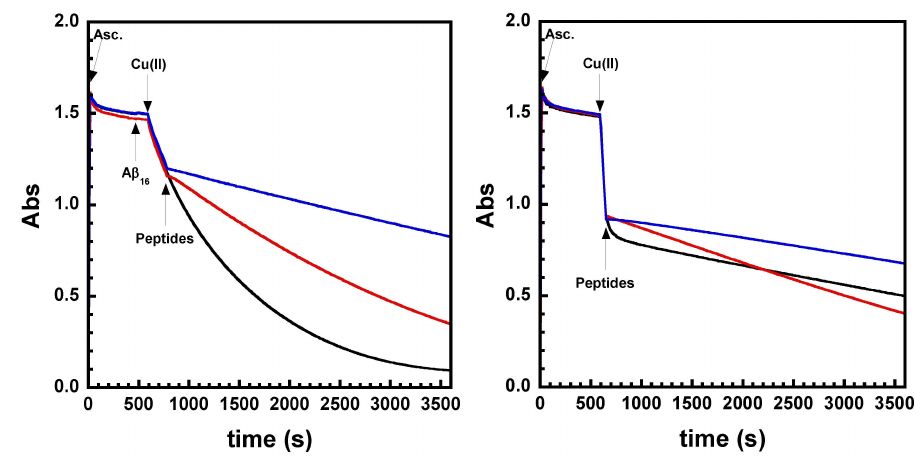
Figure 1. Ascorbate consumption (measured at λ = 265 nm) as a function of time. Ascorbate was added first, followed by A β 1–16 (right panel) after 6 min, and Cu II after 10 min, and the peptides (AH in red, AAH in black, and AHH in blue) when an absorbance of 1.0 ( left ) or 1.2 ( right ) was reached. Measurements were performed in 50 mM HEPES buffer (pH 7.5) at 25 ◦ C with continuous stirring. Final concentrations: [Asc] = 100 µ M, [A β ] = 12 µ M, [Peptide] = 12 µ M, Cu II = 10 µ